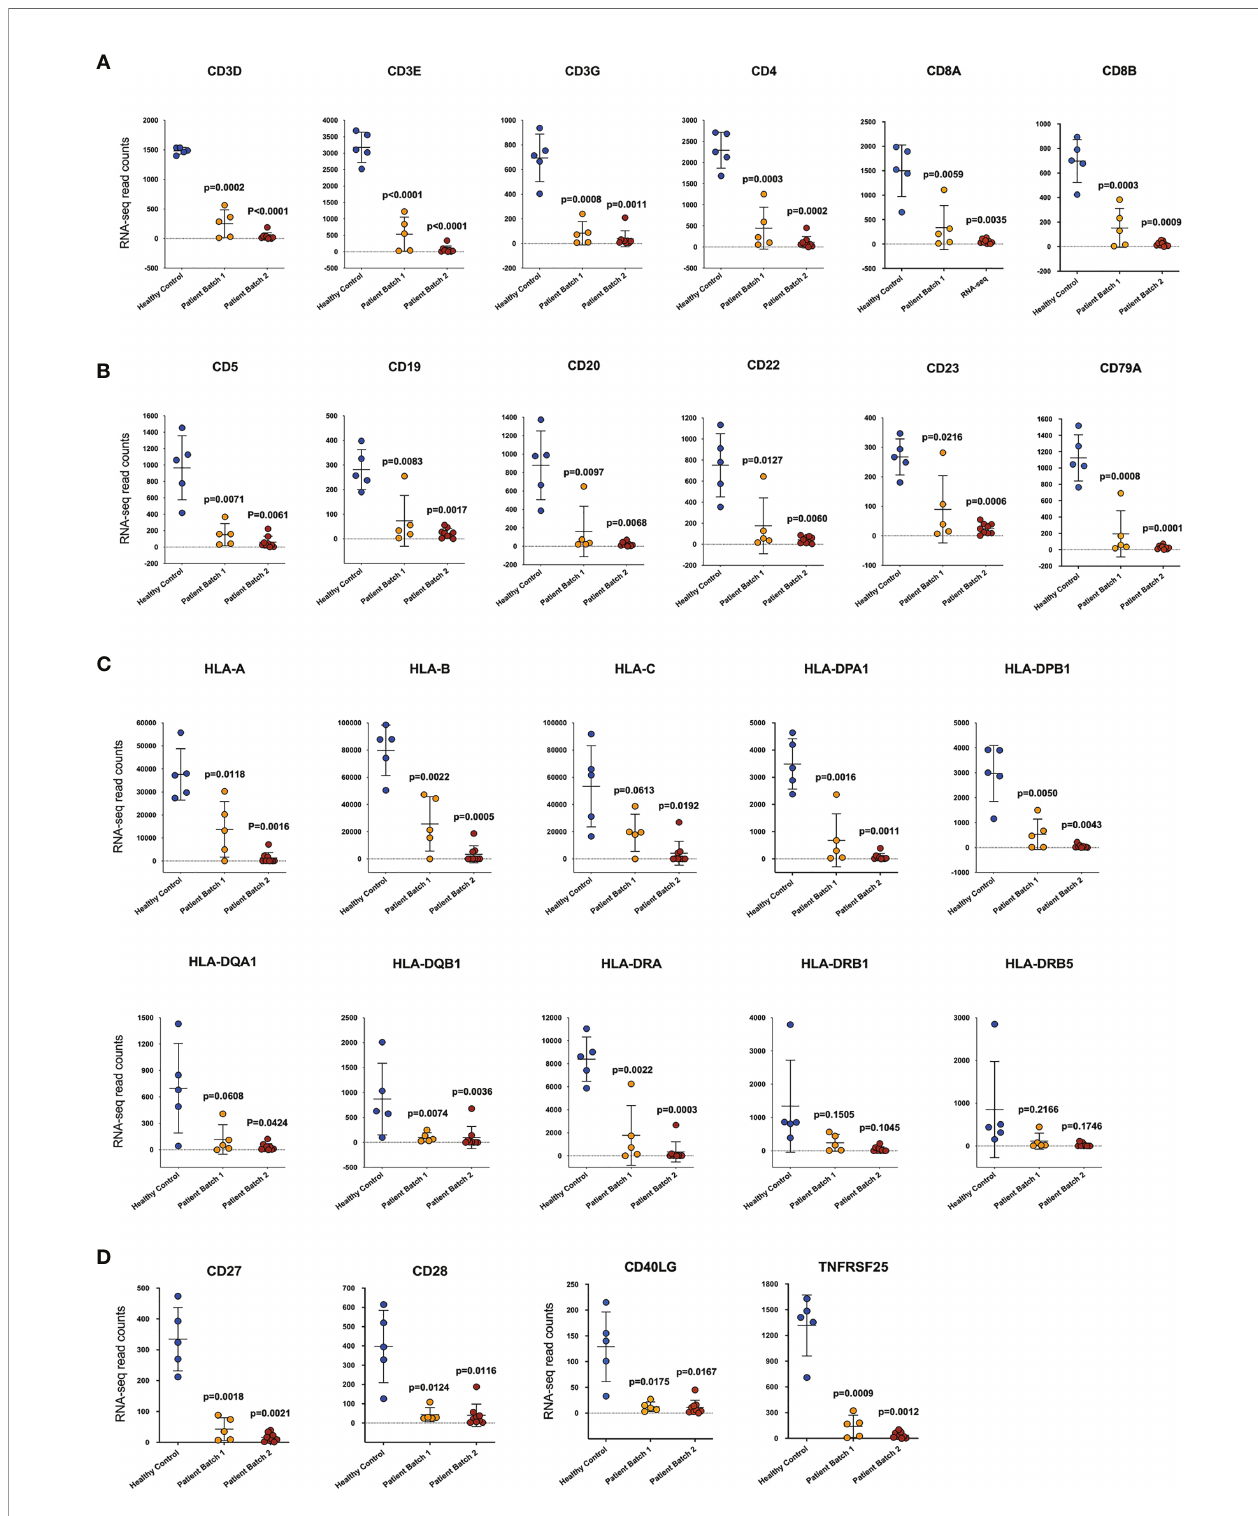
FIGURE 4 | The adaptive immune function of all patients was severely impaired. The transcription level of genes related to T cells (A) , B cells (B) , HLA molecules (C) and costimulatory molecules (D) . The abscissa shows the sample source, including healthy controls (HCs) and patients from two batches, and the ordinate shows the gene transcription level by RNA-sequencing read counts. The unpaired, 2-tailed parametric t test with Welch ’ s correction was used to compare the patient group and the heathy control group. The p values were shown in each